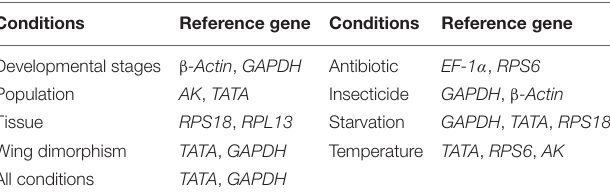
TABLE 3 | Recommended reference genes for R. padi under various experimental